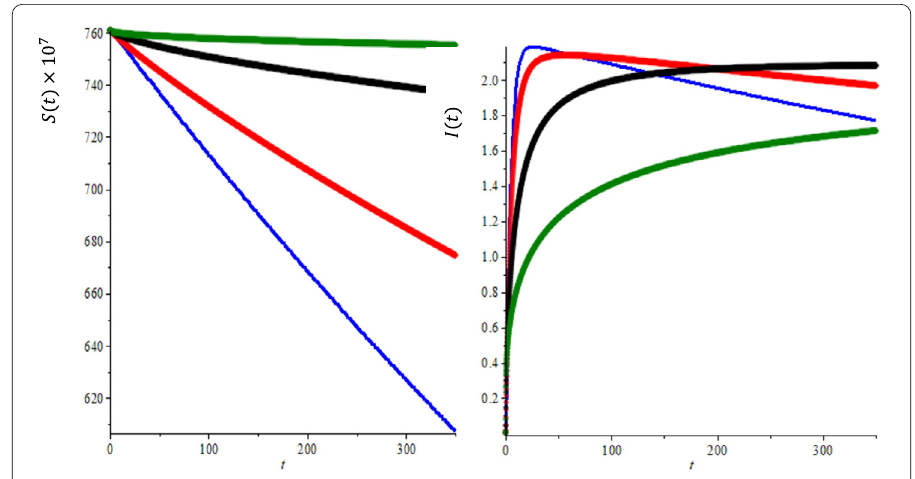
Figure 2 Comparison of the results of integer order derivatives (blue line, α = 1), fractional order of derivatives ( α = 0.9 (red line), α = 0.7 (black line) and α = 0.5 (green line) for b = 100 and R 0 =